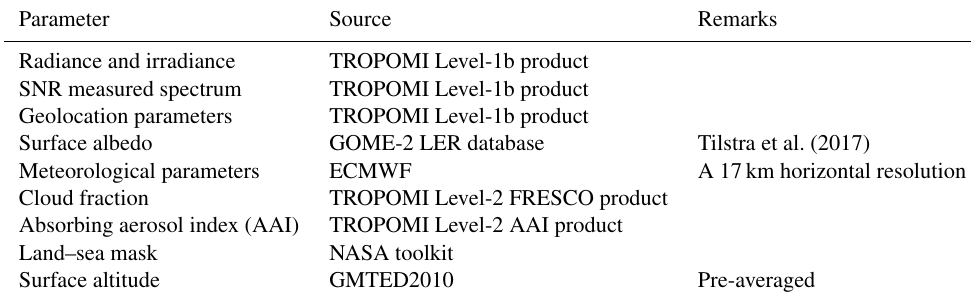
Table 1. Input parameters required for retrieving aerosol layer height using TROPOMI measured